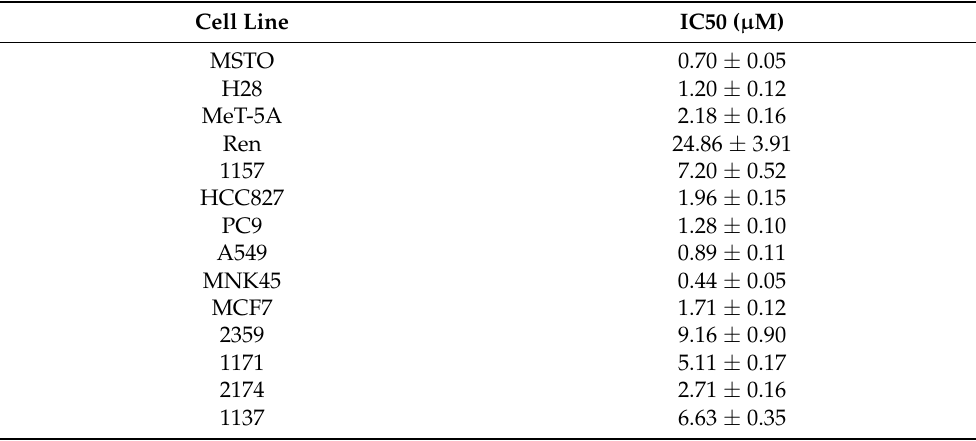
Table 2. PND-1186 IC50 of all of the cell lines tested.